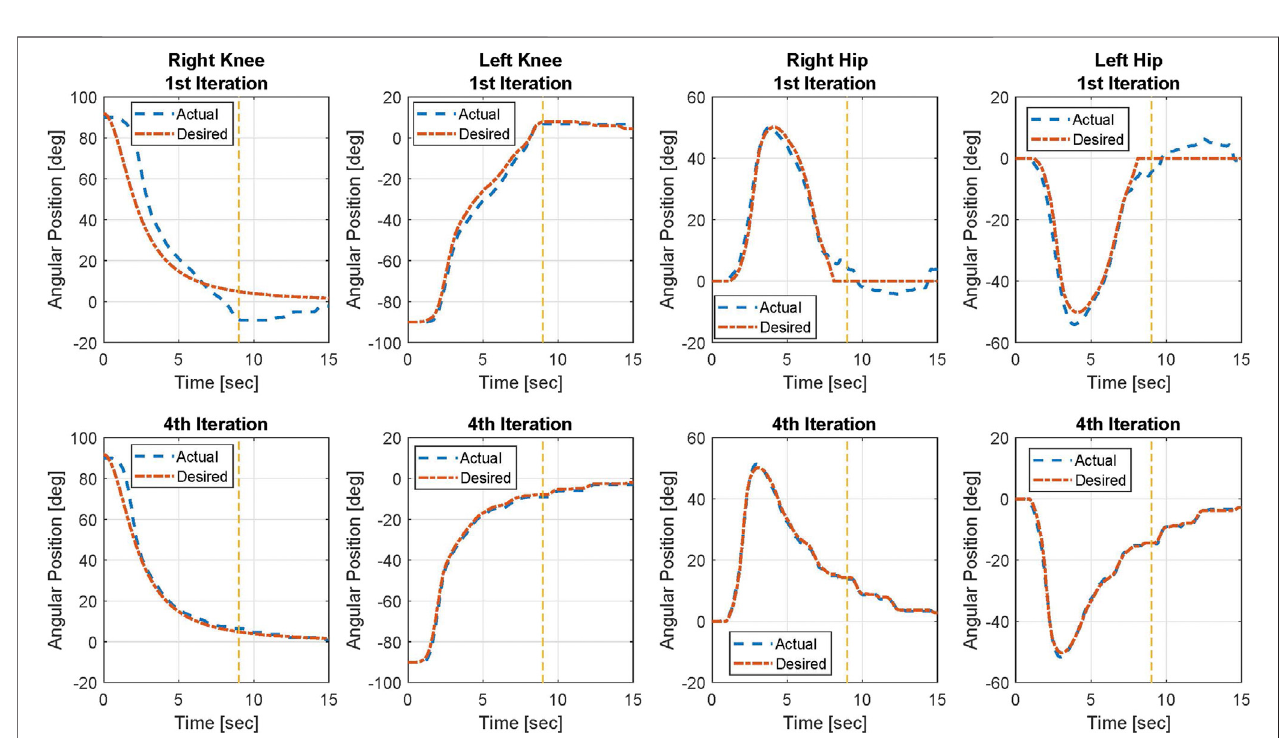
FIGURE3| KneeandhipjointangularpositiontrackingresultsofParticipant2inthe1stand4thiterations.Yellowdashedlineshowstheapproximatetimeinwhich the sit-to-stand movement is mainly done.